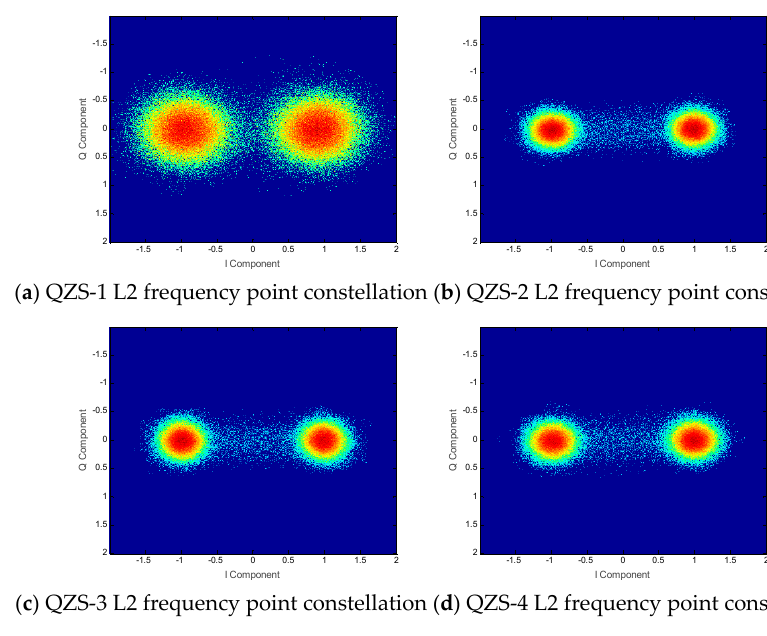
Figure 7. QZSS satellite L2 frequency constellations.